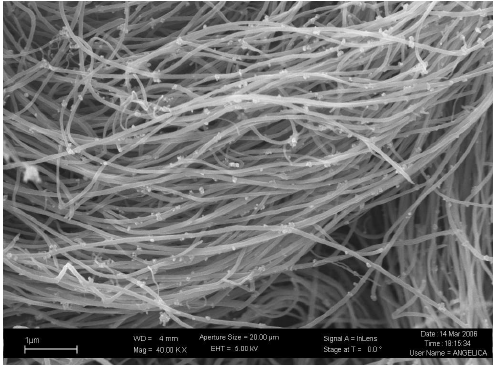
Figure 3: Scanning electron microscopy (SEM) micrograph of a bundle of MWCNTs produced by CVD technique from camphor and